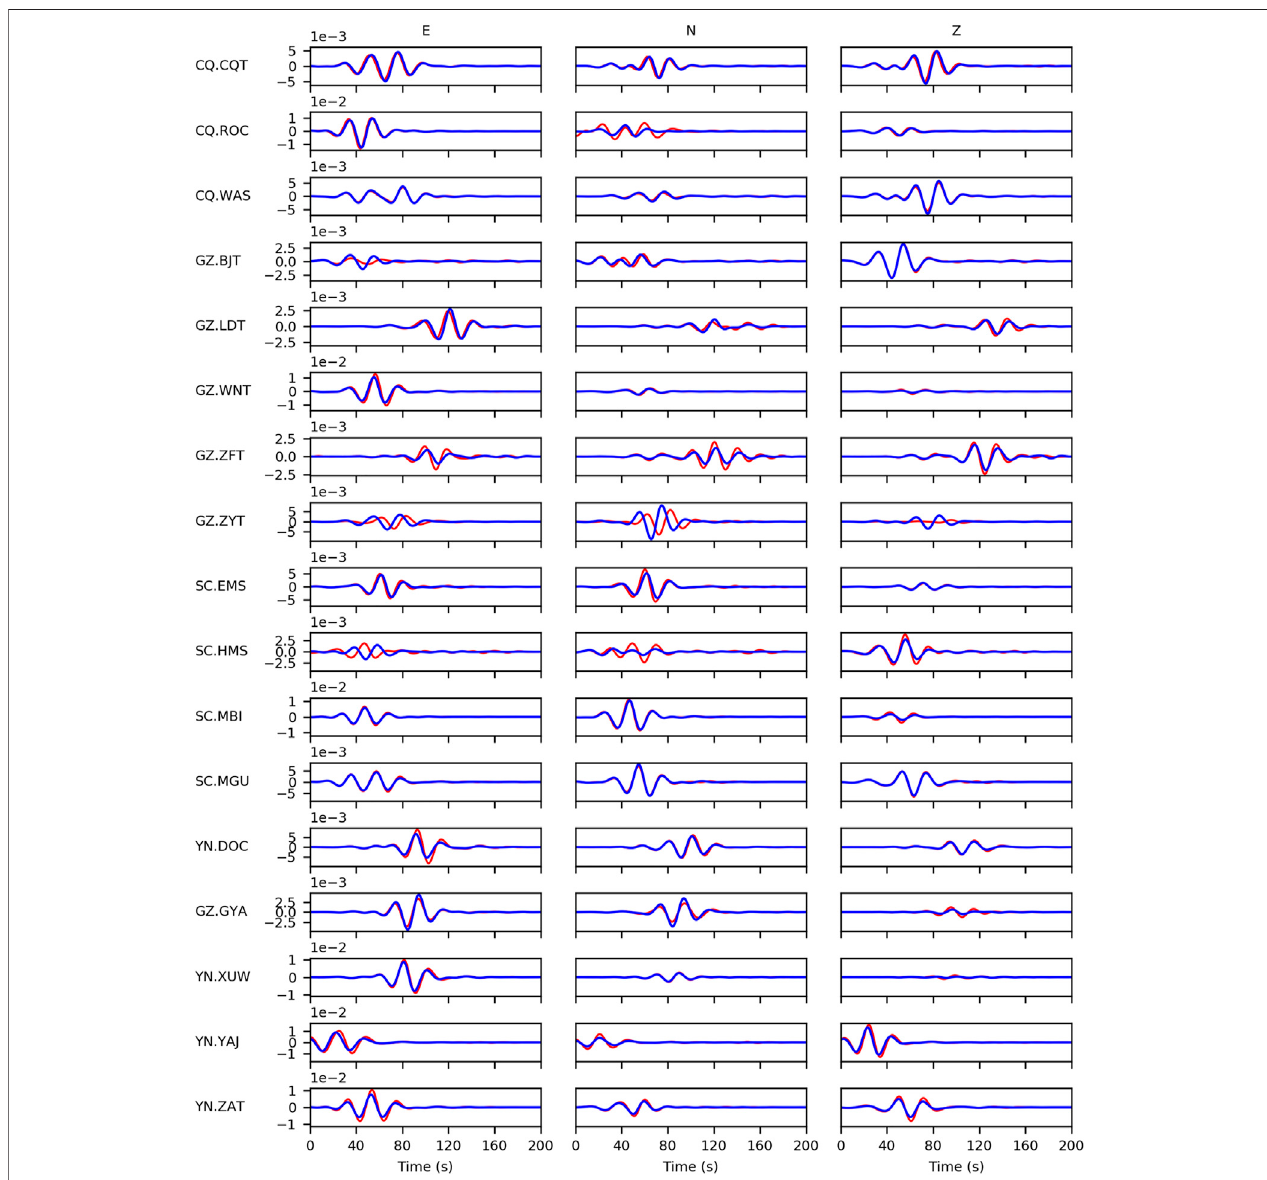
FIGURE 11 | The waveform fi ttings (0.03 – 0.06 Hz) of the whole three-component data at all stations with the origin time of Table 1 . The red and blue solid lines indicate the observation and the synthetic data using the optimum source position and mechanism, respectively. Here, the arti fi cial time shifts are not applied. The leftmost texts in each row mark the seismic network and station